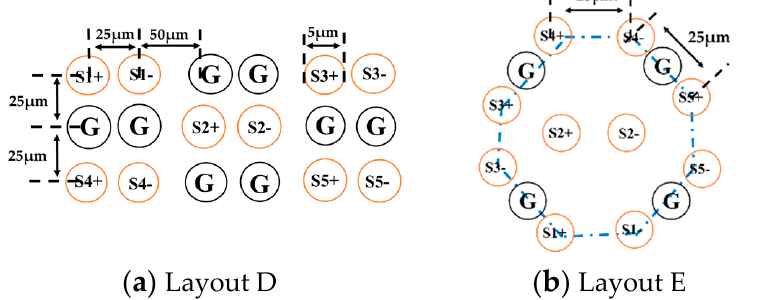
Figure 5. Two arrays of TSV array: ( a ) five pairs of differential signal TSV in staggered array, ( b ) five pairs of differential signal in octagonal TSV array.